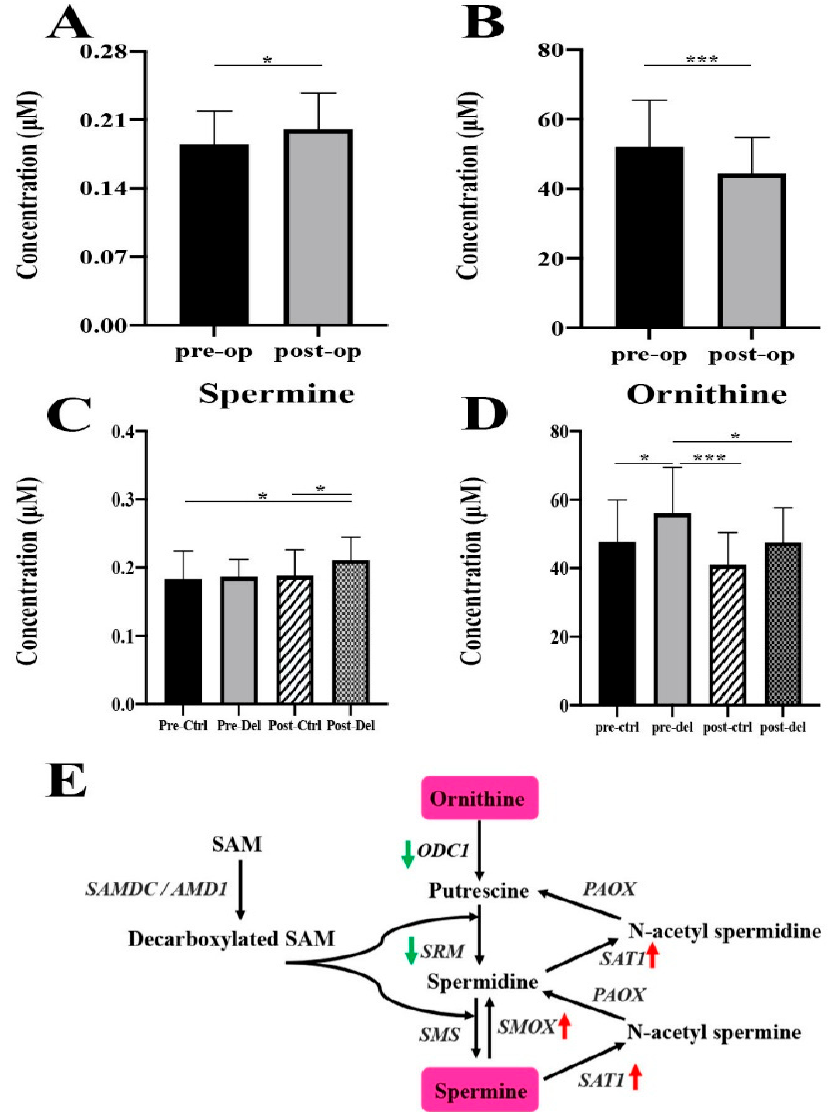
Figure 1. Plasma levels of spermine and ornithine differ between control and delirium. Spermine ( A ) and ornithine ( B ) concentrations ( µ M) in pre- and post-op samples. Spermine ( C ) and ornithine ( D ) concentrations ( µ M) in pre- and post-op samples with control and delirium. ( E ) shows